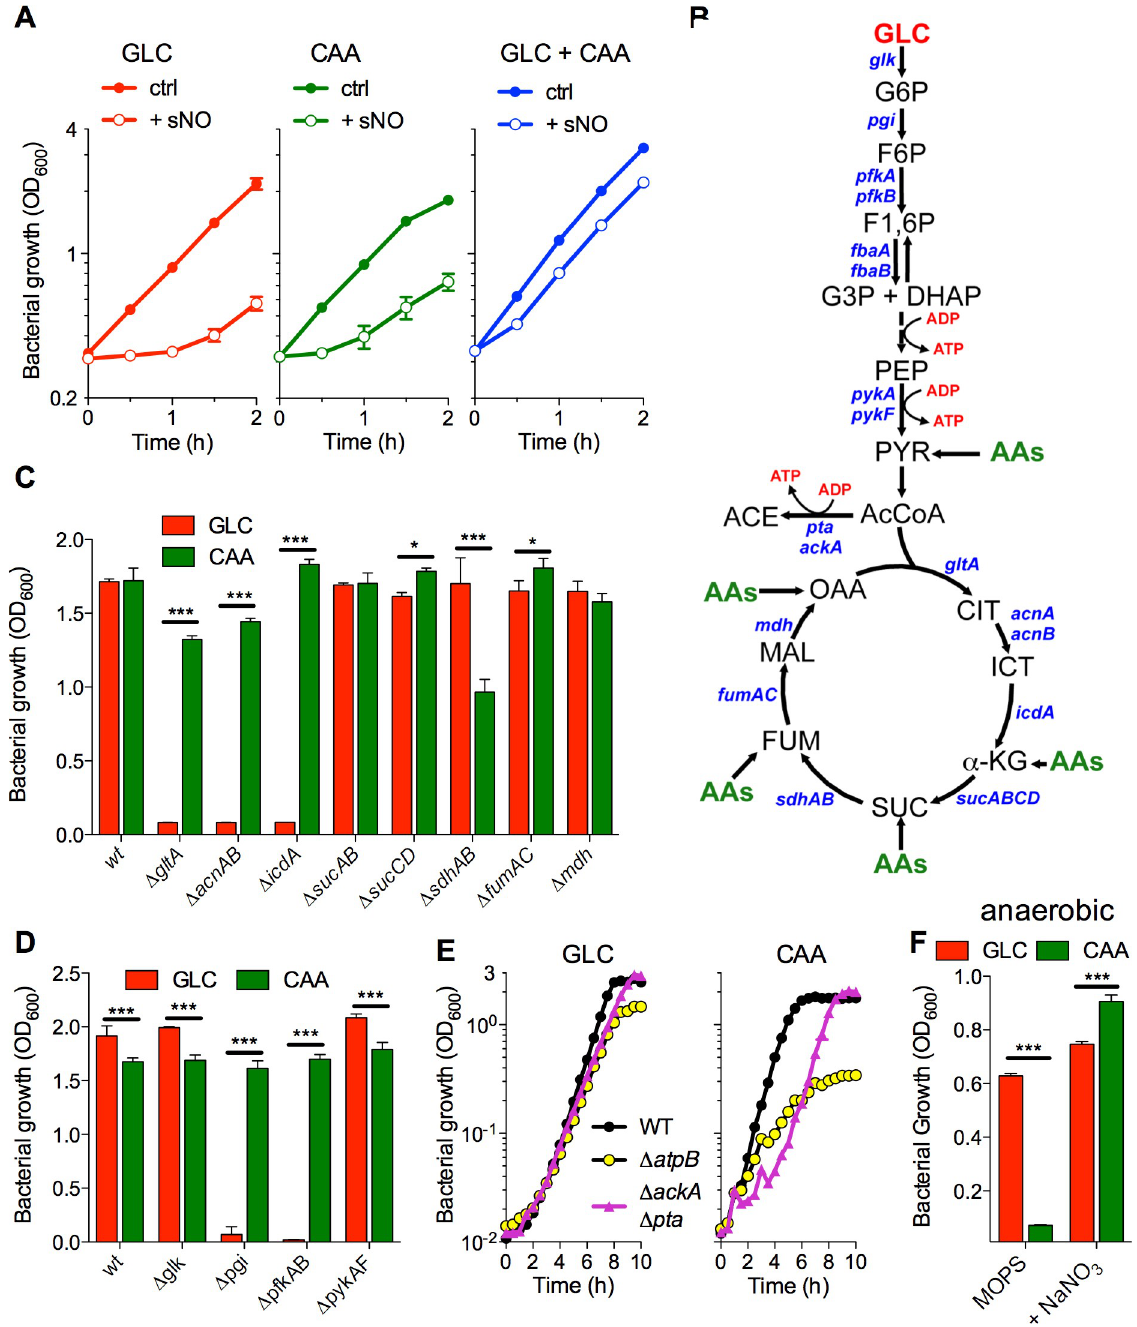
Fig 1. Effects of carbon sources on resistance of Salmonella to NO. (A) Growth of Salmonella treated (+ sNO) or untreated (ctrl) with 750 μ M of spermine NONOate in MOPS minimal media supplemented with either glucose (GLC), casamino acids (CAA), or both carbon sources (GLC + CAA) (N = 4, mean ± S.E.M.). (B) Depiction of genes in glycolysis and tricarboxylic acid cycle (TCA) targeted for mutation. Sites of entry of GLC and CAA into glycolysis and TCA are shown. Steps of ATP synthesis by substrate-level phosphorylation and fbaAB genes encoding fructose bisphosphate aldolase are also indicated. Growth of Salmonella harboring mutations in TCA (C) or glycolysis (D) after 20 h of growth in MOPS minimal media supplemented with GLC or CAA (N = 3, mean ± S.E.M.). (E) Growth of wild-type (WT), Δ atpB , and Δ ackA Δ pta Salmonella in MOPS supplemented with GLC or CAA (N = 4, mean ± S.E.M.). (F) Anaerobic growth of Salmonella in MOPS media supplemented with 50 mM NaNO 3 (N = 4, mean ± S.E.M.). � , p < 0.05; ��� ; p < 0.001.